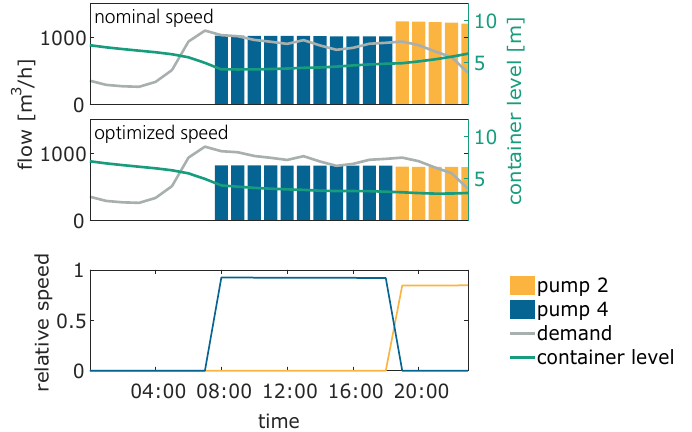
Figure 9. Pump schedule with pumps running at a nominal speed (upper panel) compared to the pump schedule resulting from speed optimization (second panel). In the lower panel, the optimized speeds of the pumps in the second panel are shown.